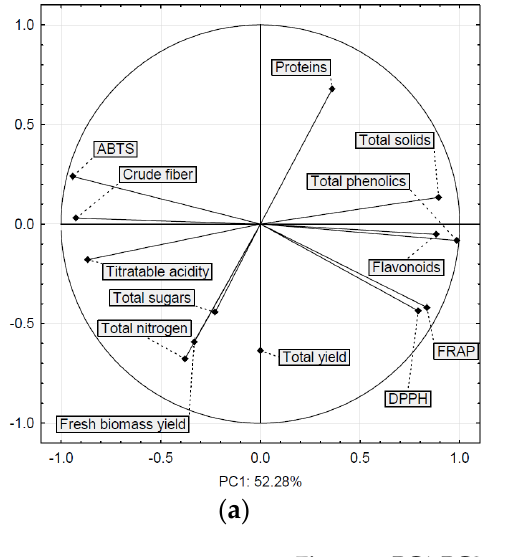
Figure 2. PC1-PC2 presentations as a result of PCA of onion samples deriving from 32 treatments (for the legend, see Appendix A): ( a ) loadings and ( b ) scores plot.